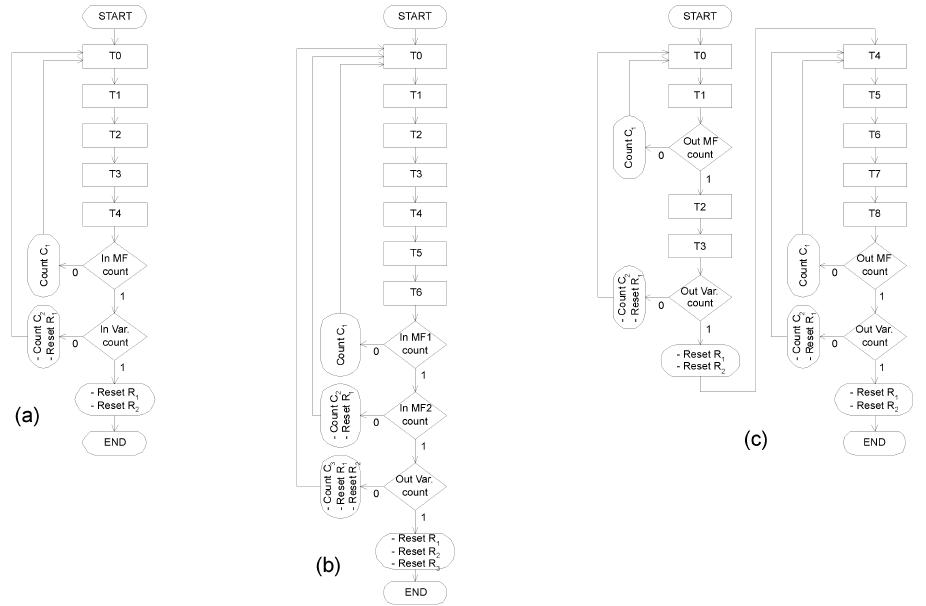
FIGURE 6 Finite State Machine (FSM) control of (a) fuzzifier, (b) rule base and (c)